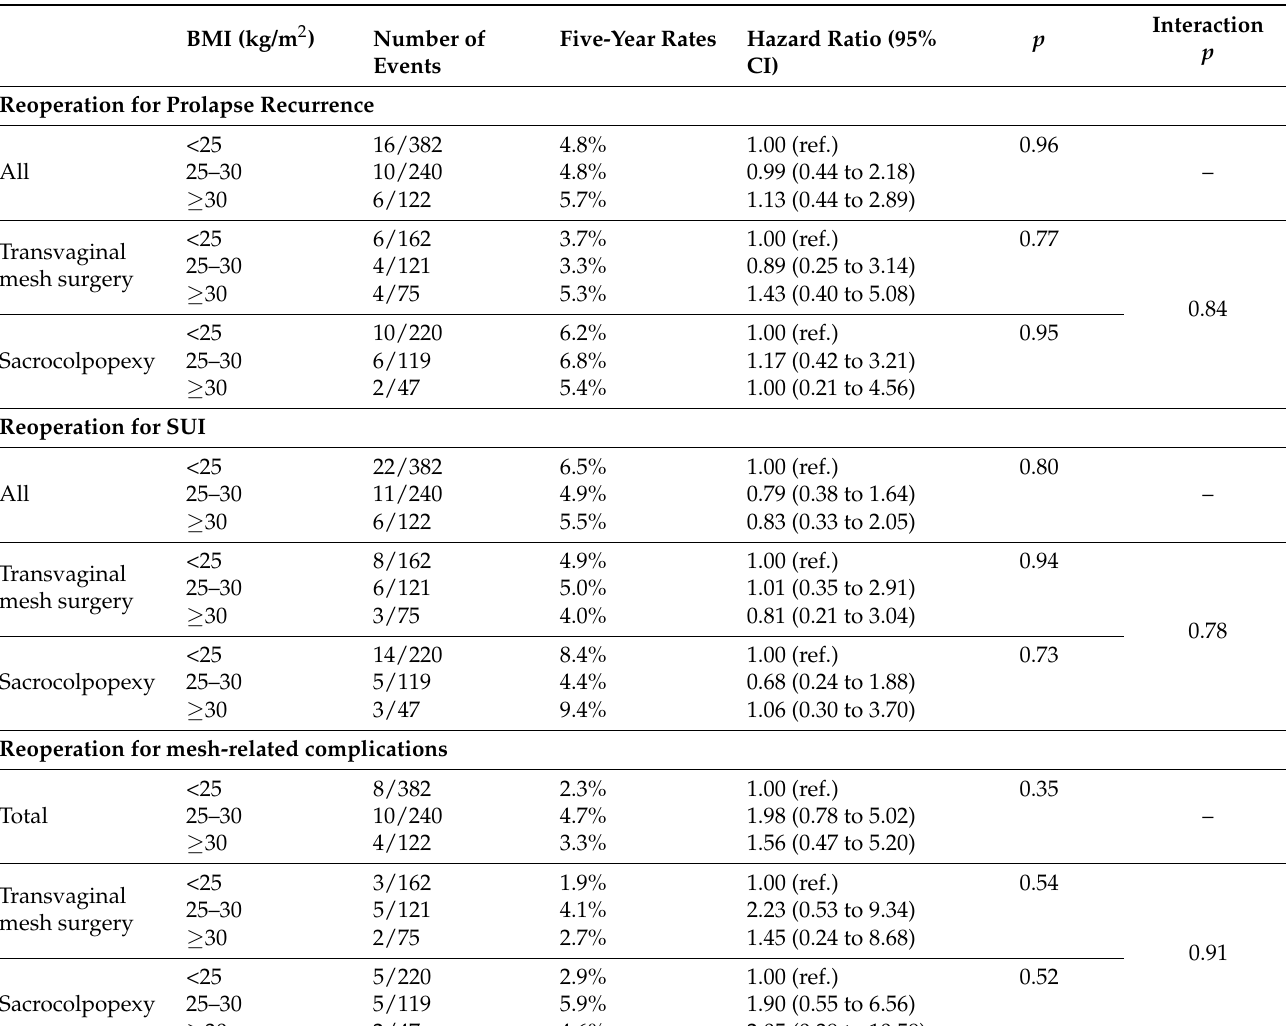
Table 3. Comparisons between the three BMI groups according to the initial surgical approach of reoperation for prolapse recurrence, reoperation for SUI and for mesh-related